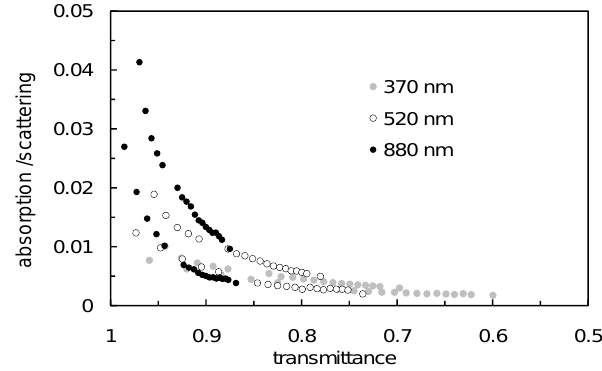
Fig. 10. Remaining cross sensitivity of absorption to particle scat- tering as a function of filter transmittance for the 3 λ -PSAP. Ab- sorption coefficients were corrected using Bond et al. (1999).